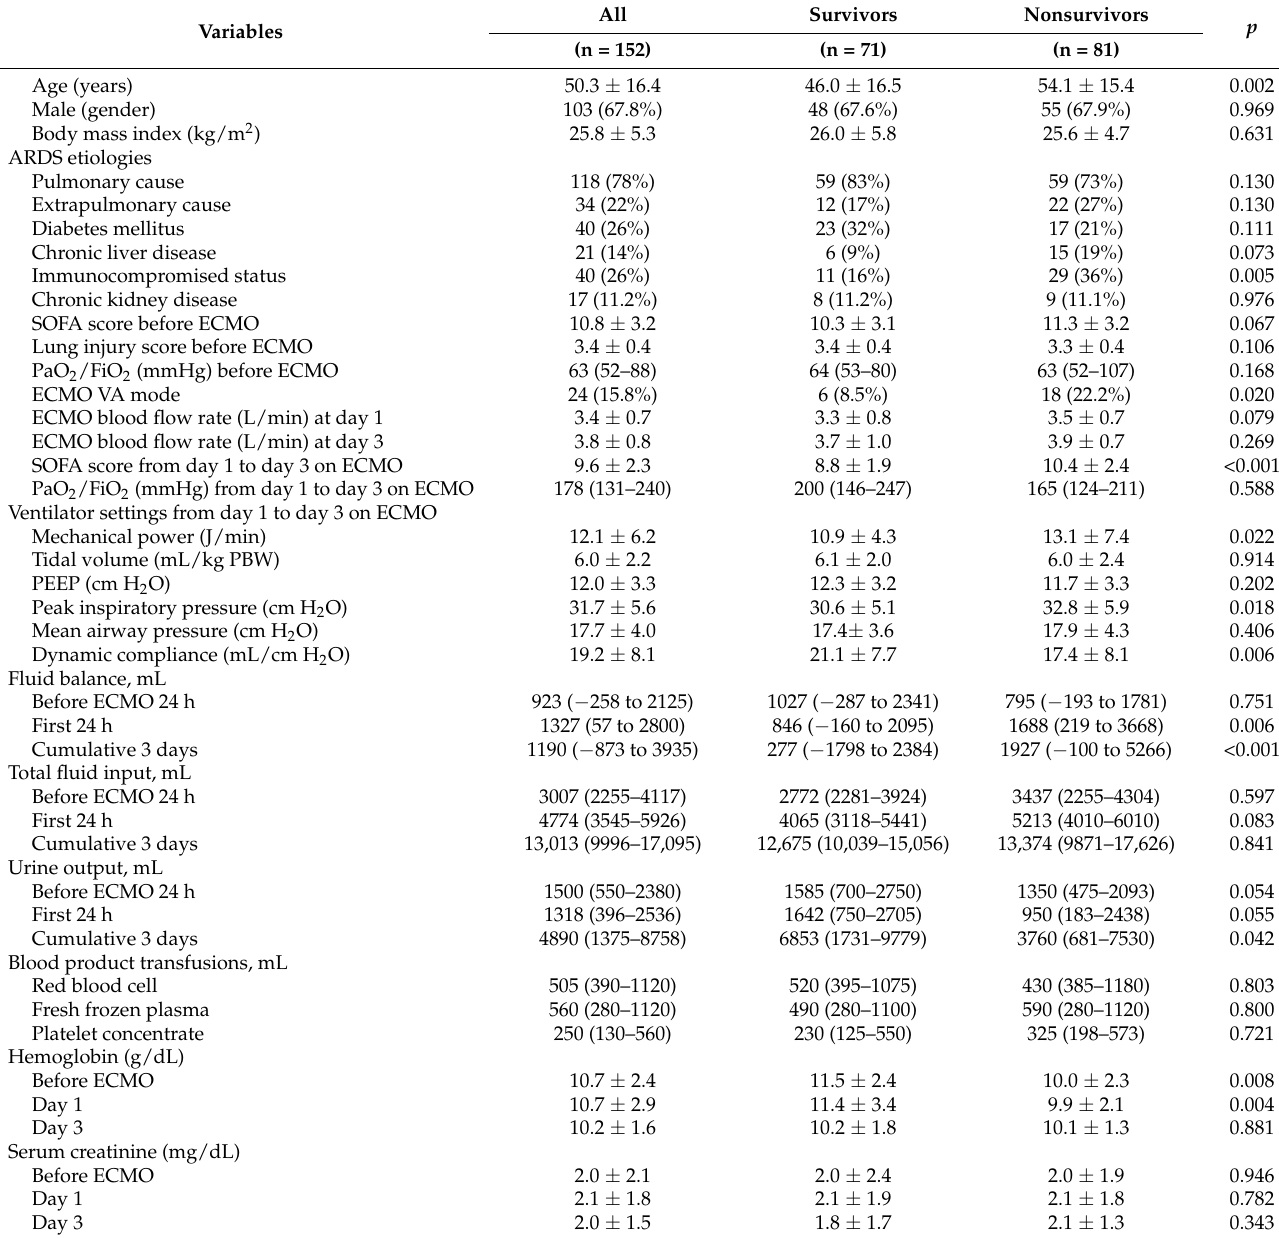
Table 1. Background characteristics and clinical variables: survivors and